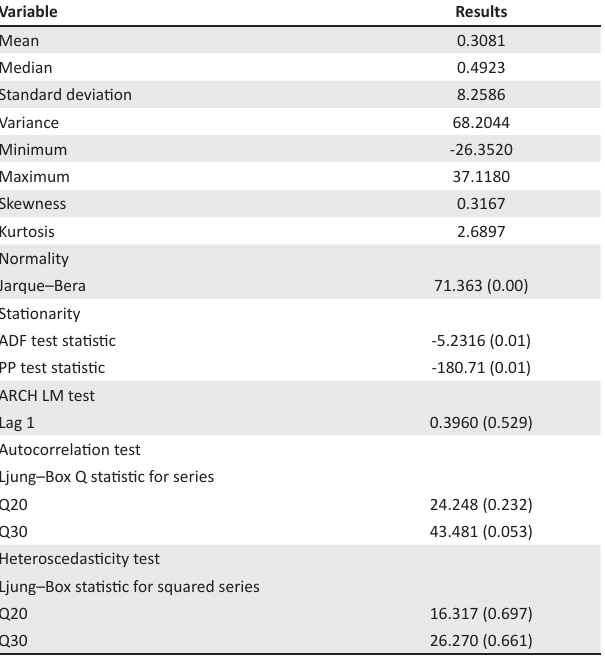
FIGURE 5: South Africa – Peak over threshold estimates to determine the threshold value.